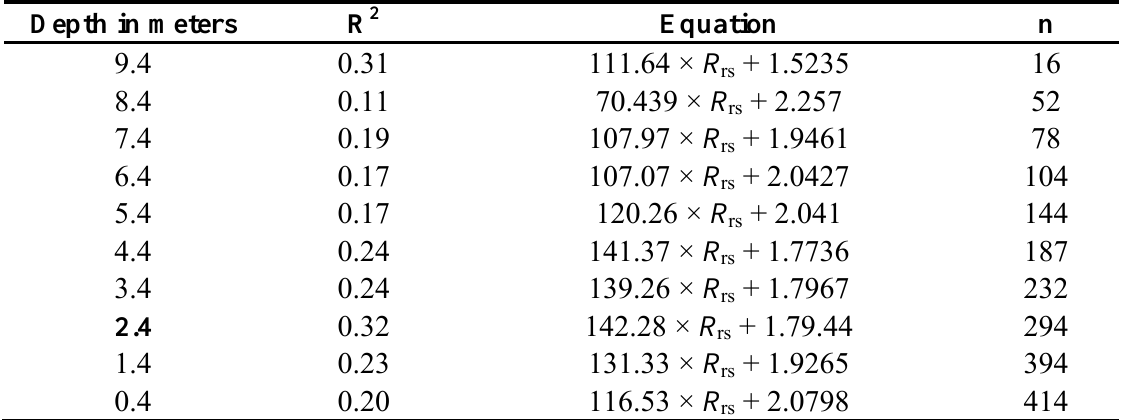
Table 1. Relationships between in situ turbidity (NTU) and R depth at the moment of taking in situ turbidity